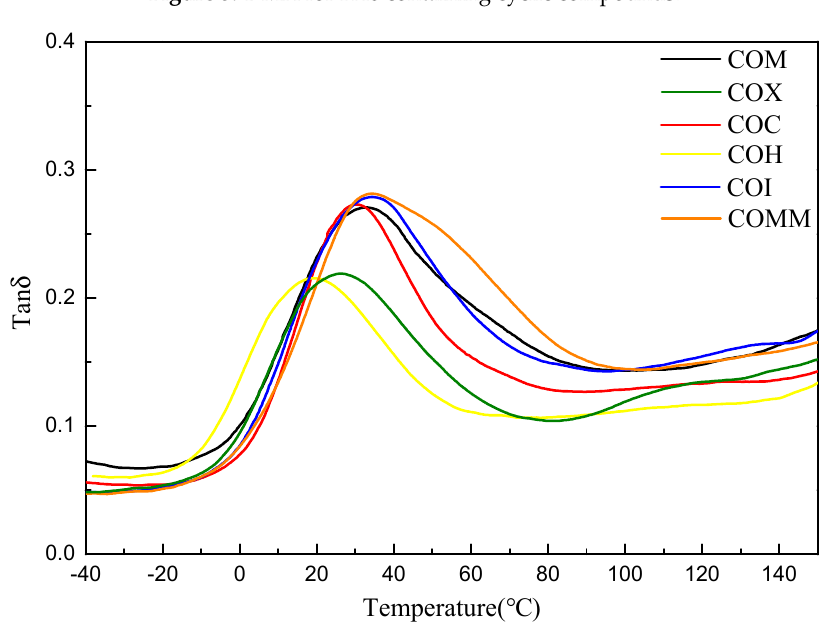
Figure 5. DMA for PA6 containing cyclic compounds.